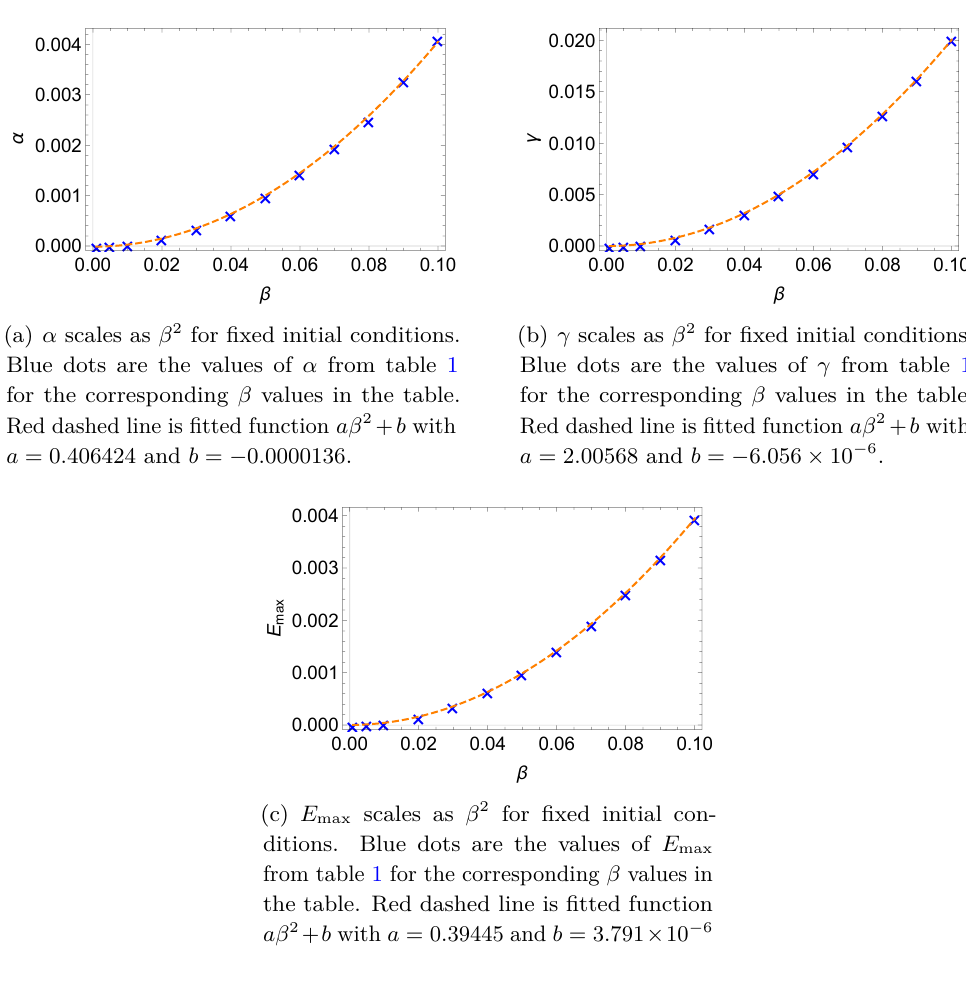
Figure 13 . Scaling of α , γ and E max with semi-holographic coupling β for initial conditions set by (4.16). We are using units in which the initial black hole mass is